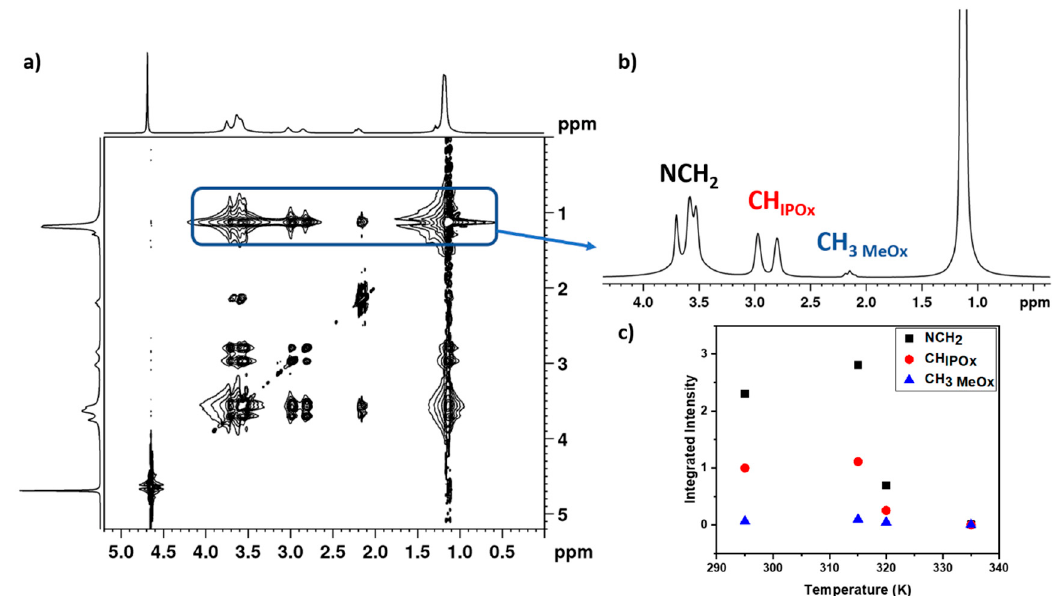
Figure 10. 2D NOESY spectrum of P(MeOx / IPOx)(14 / 86) block copolymer in D2O solution ( c = 5 wt%) measured at 315 K with mixing time 600 ms ( a ). On the right up ( b ) there is 1D slice spectrum extracted from the signal at 1.05 ppm of CH 3 protons of PIPOx units of the NOESY spectrum. Temperature dependences of integrated intensities of various signals in 1D slices extracted from the signal of CH 3 protons of PIPOx units (at 1.05 ppm) of the NOESY NMR spectra ( c ).